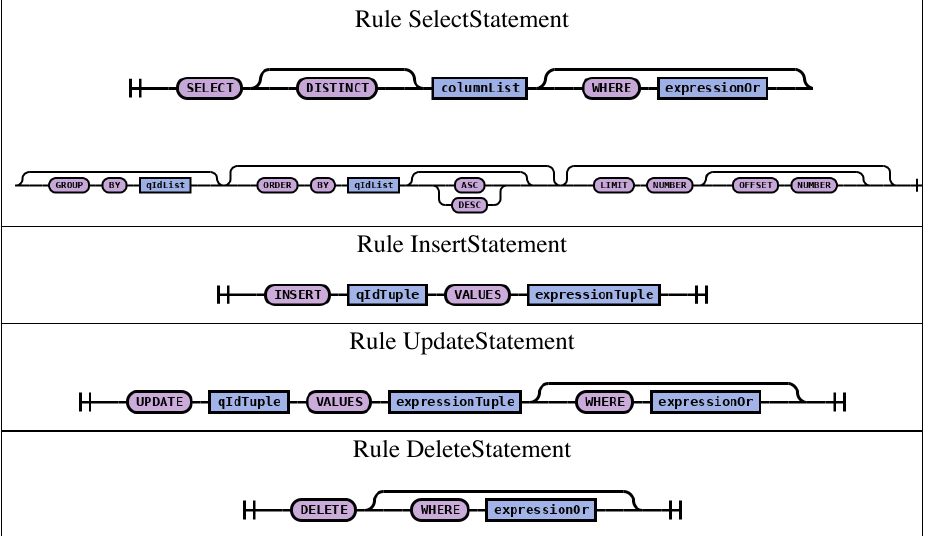
Figure 4. SQL-like SELECT, INSERT, UPDATE and DELETE statements implemented in MQL .